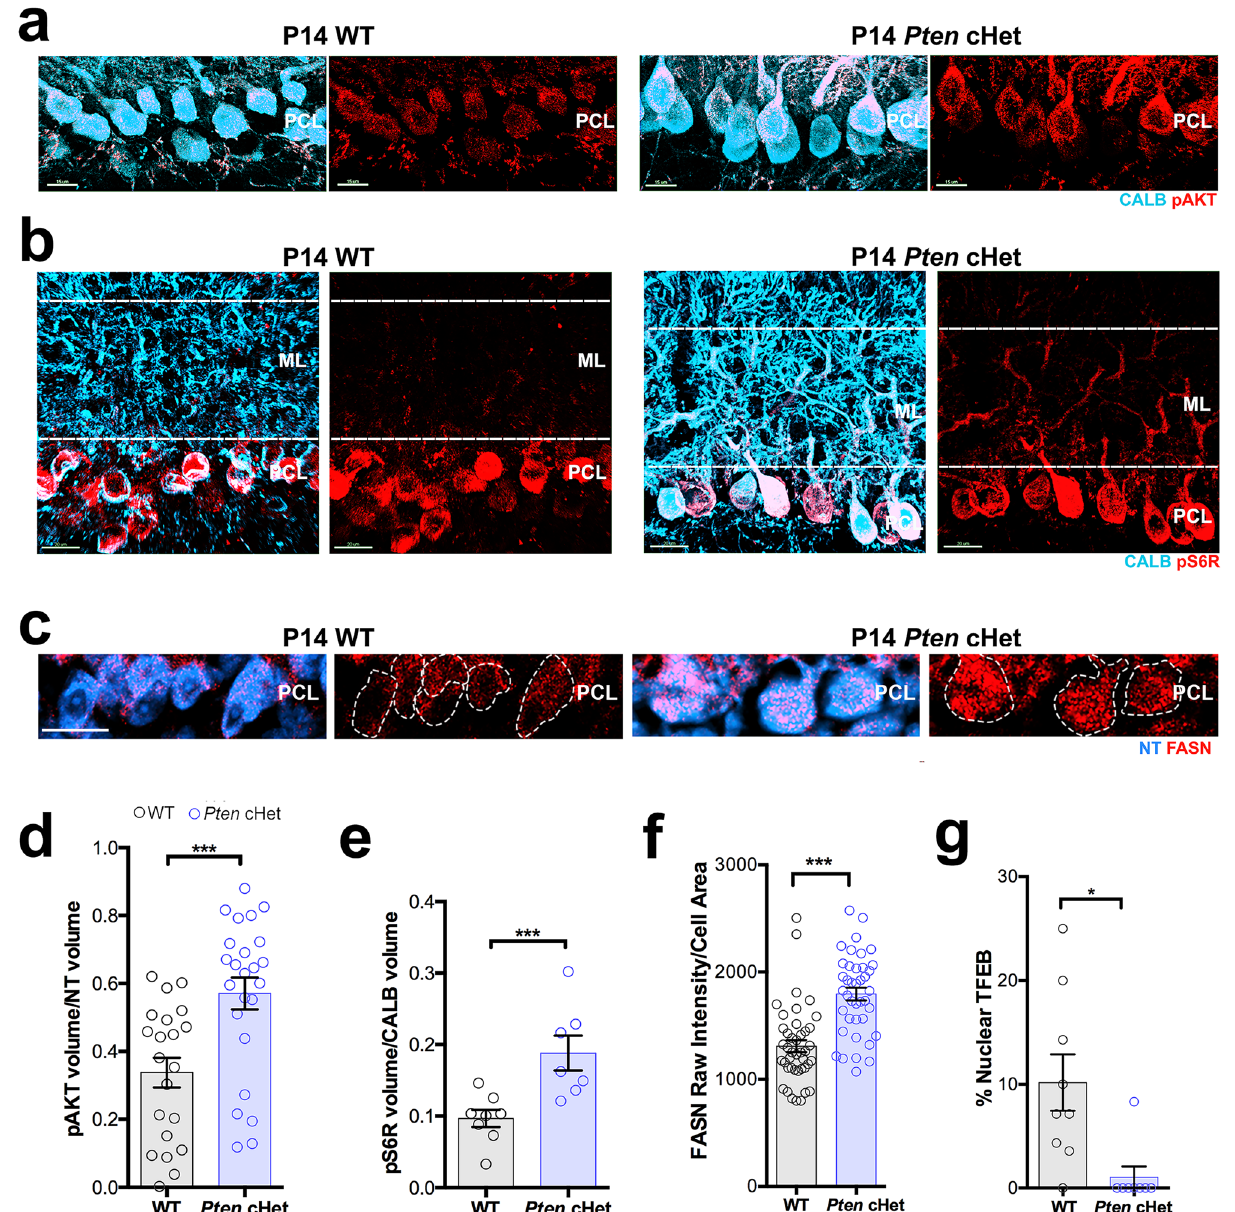
Figure 7. Overactivation of the AKT-mTORC1 pathway in Pten- cHet PCs from P14 mice. ( a ) Confocal images showing pAKT and CALB immunoreactivity in P14 PCs from WT and Pten- cHet mice. ( b ) Confocal images showing pS6R and CALB immunoreactivity in the cerebellar PCL and ML of P14 WT and Pten- cHet mice. Dotted lines indicate the region used for quantitative analysis. ( c ) Confocal images showing FASN immunoreactivity and NT staining in the cerebellar PCL of P14 WT and Pten- cHet mice. ( d ) Quantitative analysis of the ratio of pAKT volume in CALB + PC soma from WT and Pten- cHet mice at P14. Data are presented as mean ± SEM, n = 4 mice/genotype/age, 5–6 cells/mouse. ( e ) Quantitative analysis of the ratio of pS6R volume per dendritic CALB volume from WT and Pten- cHet mice at P14. Data are presented as mean ± SEM, n = 4 mice/genotype/age, 2 images/mouse. ( f ) Quantitative analysis of FASN fluorescence intensity in NT + PCs from WT and Pten- cHet mice at P14. Data are presented as mean ± SEM, n = 10 cells from 4 mice/ genotype/age. ( g ) Quantitative analysis of the percentage of PCs with nuclear TFEB from WT and Pten- cHet mice at P14. Data are presented as mean ± SEM, n = 2 images from 4 mice/genotype/age. ***P < 0.001. Scale bars: ( a ) 15 μm, ( b ) and ( c ) 20